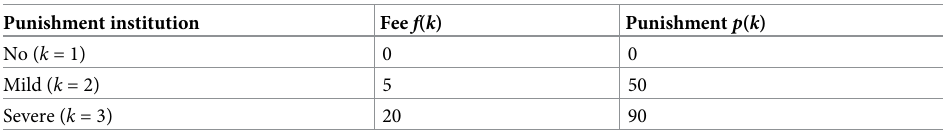
Table 1. Punishment